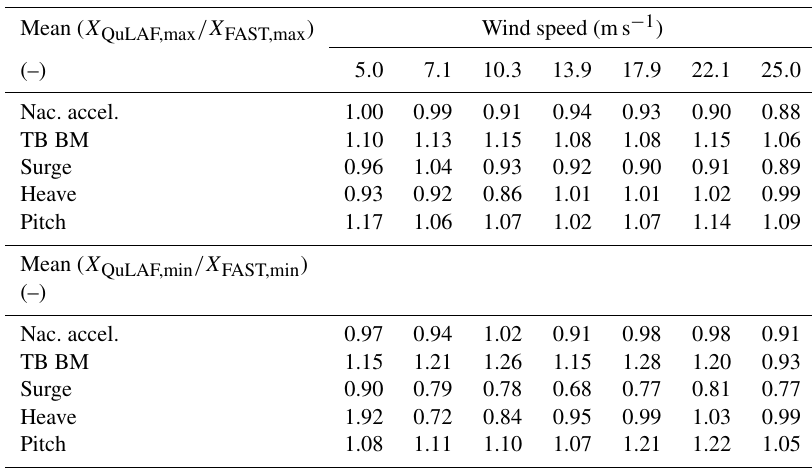
Table 8. Ratio of max. and min. response (QuLAF / FAST) averaged per wind speed for DLC